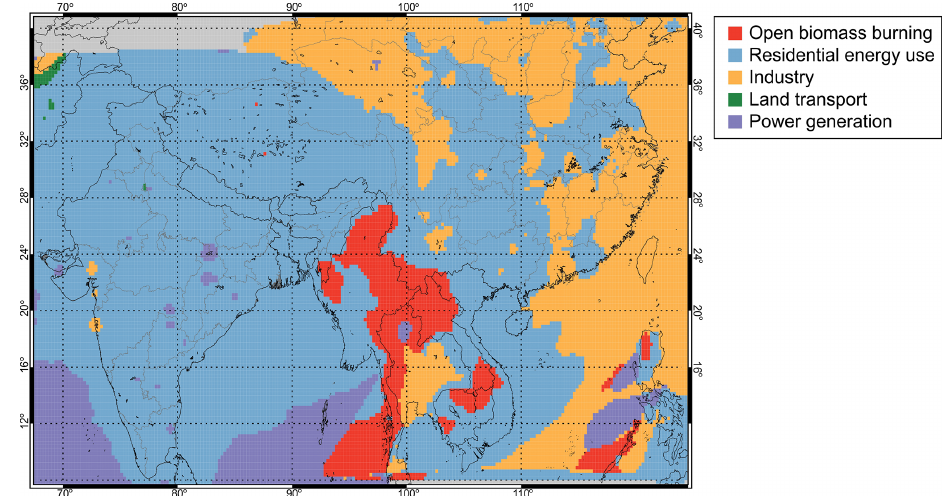
Figure 4. Spatial distribution of the dominant anthropogenic emission sectors for annual mean PM 2 . 5 in South and East Asia. The dominant emission sector is calculated for each model grid cell as the emission sector that gives the largest reduction in simulated annual mean surface PM 2 . 5 concentration, i.e. results in the largest absolute difference in µgm − 3 from the control simulation. Regions in grey are outside the model